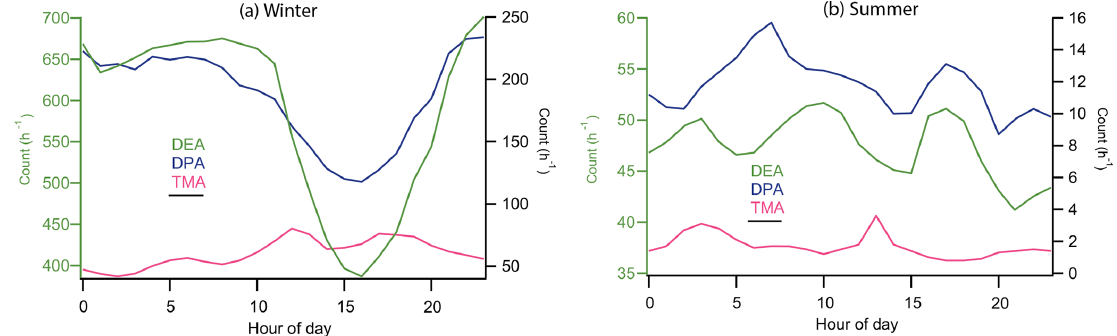
Figure 3. Diurnal profiles of amine-containing particles during both winter (a) and summer (b) . The green left axis in each panel indicates the average number count of DEA-containing particles, while the right axis represents the number count of both DPA- and TMA-containing particles.